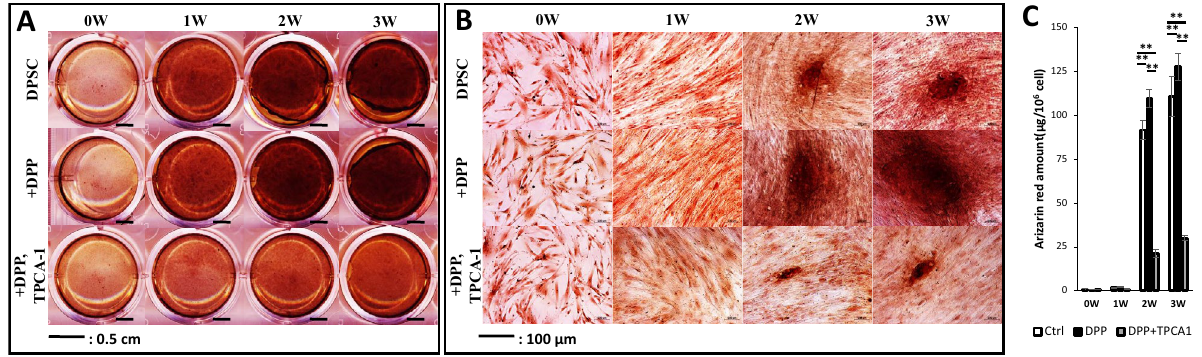
Figure 5. DPP stimulation promotes matrix mineralization by activation of NF-κB signaling. ( A ) DPSCs stimulated with 500 ng DPP in the presence and absence of the inhibitor TPCA-1 were cultured under differentiation conditions over a period of 0,7,14 and 21 days and mineralized nodules containing calcium were visualized using Alizarin Red staining. ( B ) Higher magnification of (A) show calcium deposits in the mineralization cultures at various time points. ( C ) Quantitative measurement of calcium deposition was determined by measuring the absorbance of the eluted Alizarin Red stain at 562 nm on a multiplate reader using a standard calcium curve. Statistically significant differences are indicated at 2 and 3 week *p < 0.05, **p <